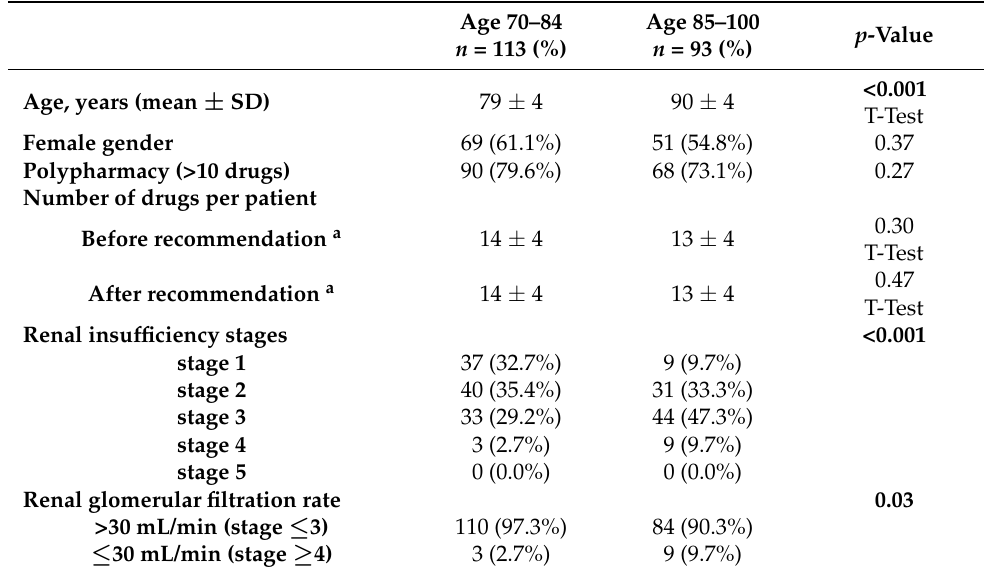
Table 1. Characteristics of study populations.